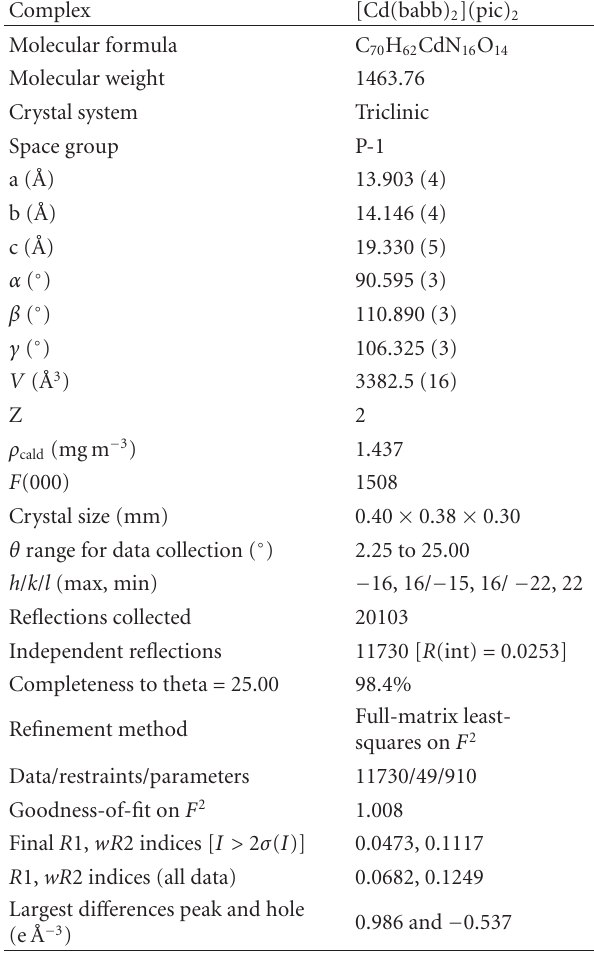
Table 1: Crystallographic data and data collection parameters